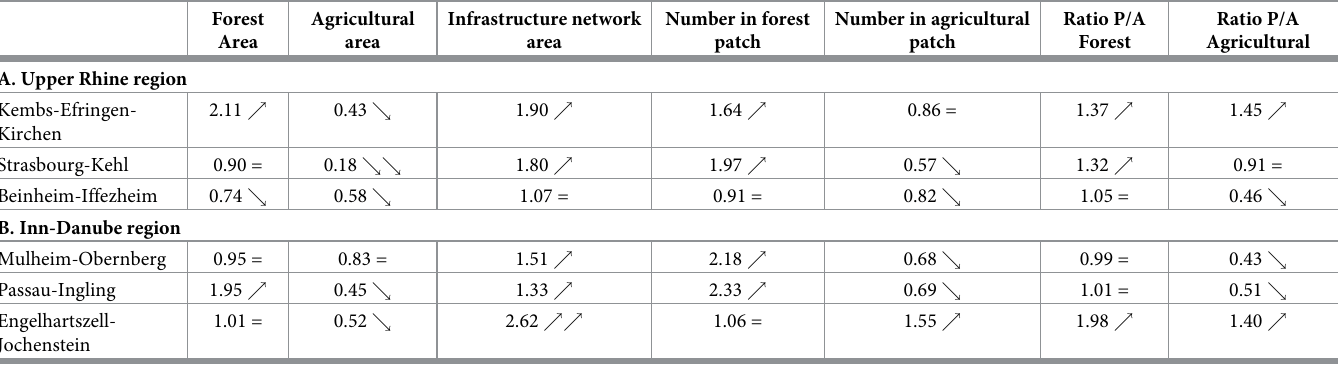
Table 1. Evolution of five metrics using the multiplying coefficient (Cm) between the most recent (2010s) and oldest date (1950s).